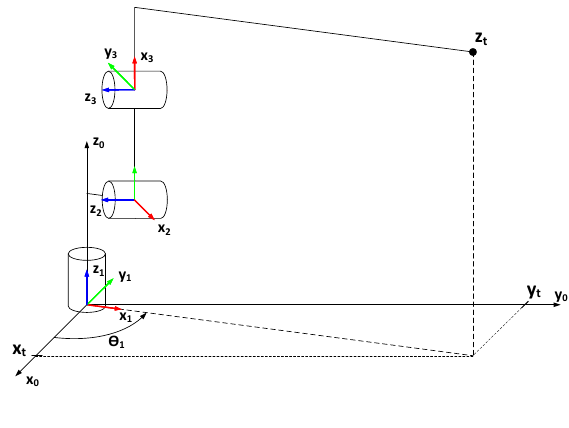
Figure 13: Geometric approach for base joint θ 1 . Without considering the rotation of the robot base, the system can be simplified and considered as a planar two-link elbow system, where the inverse kinematics of such a configuration has two possible solutions; elbow- down and elbow-up . An illustration of the Comau robot in a planar two-link configuration is shown in Figure 14, where the link a 1 and line B symbolizes the two- link elbow system.